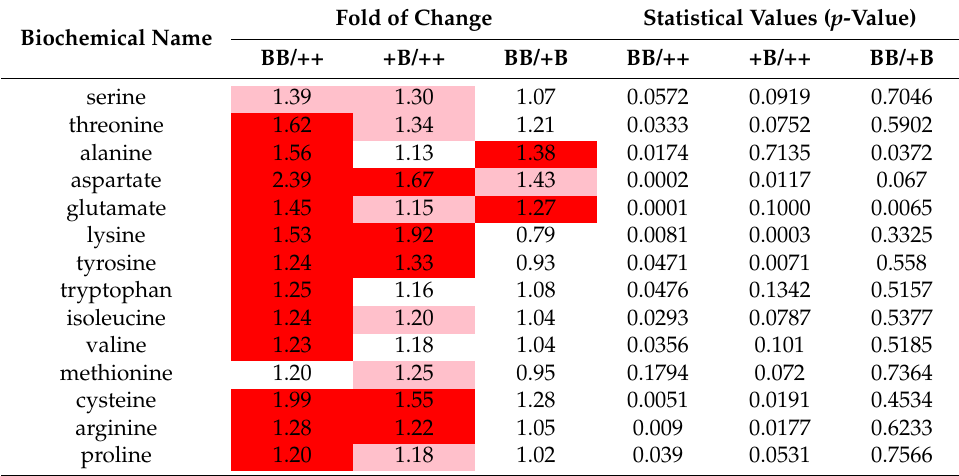
Table 2. Levels of amino acids comparing in